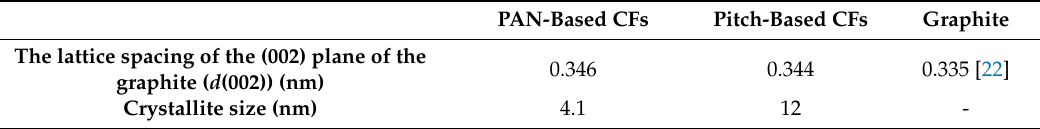
Table 4. Values of the lattice spacing of the (002) plane of the graphite ( d (002)) and crystallite size of PAN- and pitch-based CFs, and graphite from the literature. PAN-Based CFs